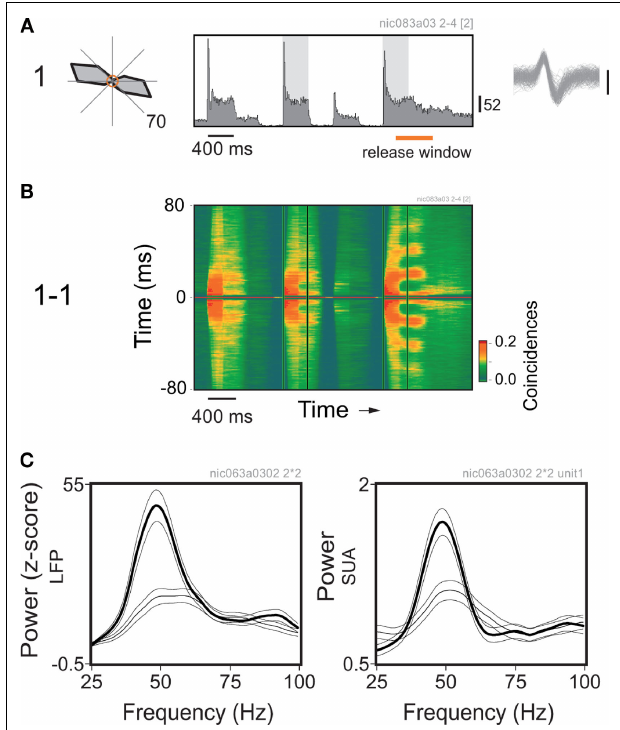
FIGURE 5 | Perceptual readiness modulates gamma power in V1 of the monkey. (A) Average response histogram for a single cell to a Gabor element centered over its receptive fi eld. The orientation of the Gabor element changes at 400 ms steps. Notice the strong responses for the epochs of orientation match. Analysis windows are indicated by the shadowed rectangles on the plot. Direction tuning is shown on the left. Spontaneous activity is represented by the central circle, maximum average rate is indicated at the bottom right of the plot. (B) Sliding window autocorrelation for the responses shown above. Plots are aligned in time. Autocorrelation functions were computed for 200 ms windows at steps of 50 ms. (C) Corresponding power spectra obtained for the local fi eld potential (LFP) and spiking activity recorded from the same electrode. Thin line: window of match in the middle of the trial. Thick line: window of match prior to the behavioral response (in this example, coincides with the appearance of the embedded fi gure). Multitaper spectral analysis was obtained using the Chronux analysis software. Power was normalized by the fi ring rate. Thin lines around the mean indicate 95% confi dence